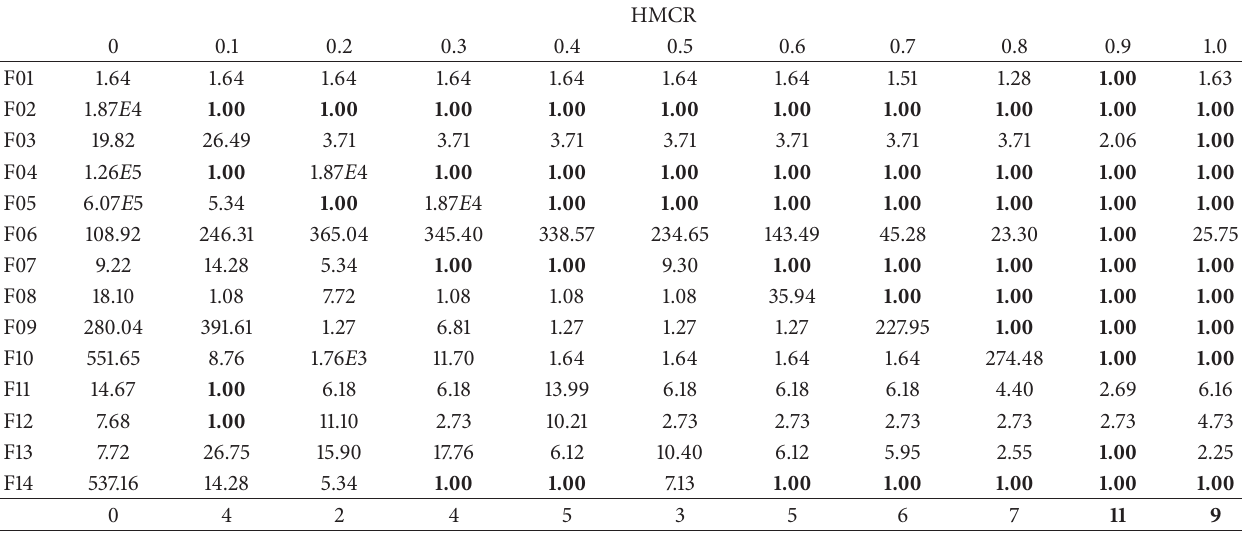
Table 9: Best normalized optimization results in fourteen benchmark functions with different HMCR. The numbers shown are the best results found after 100 Monte Carlo simulations of HS/BA